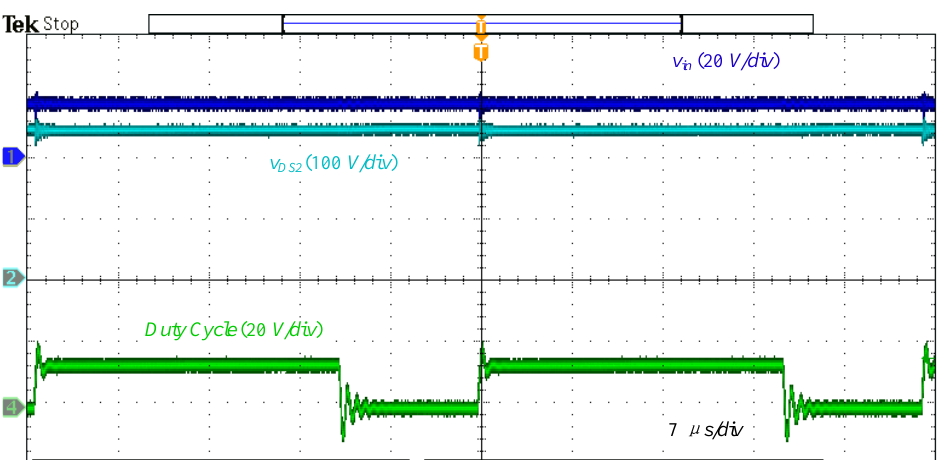
Figure 15. A case of study where the duty cycle is set to 0.65, and the input voltage is 20 V.